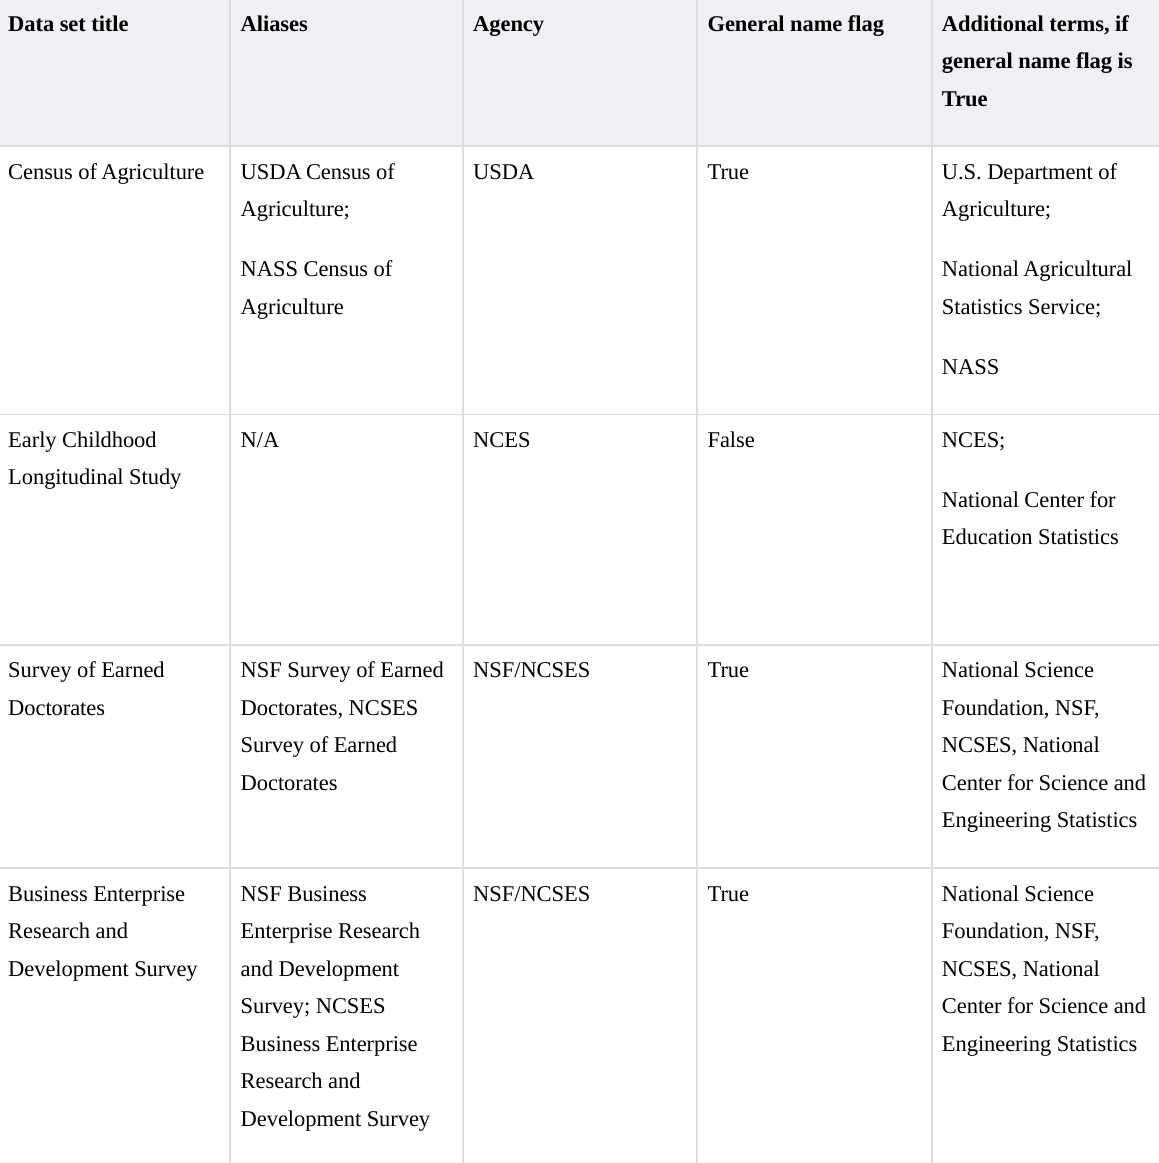
Table B2. Example of a data set entry for the string